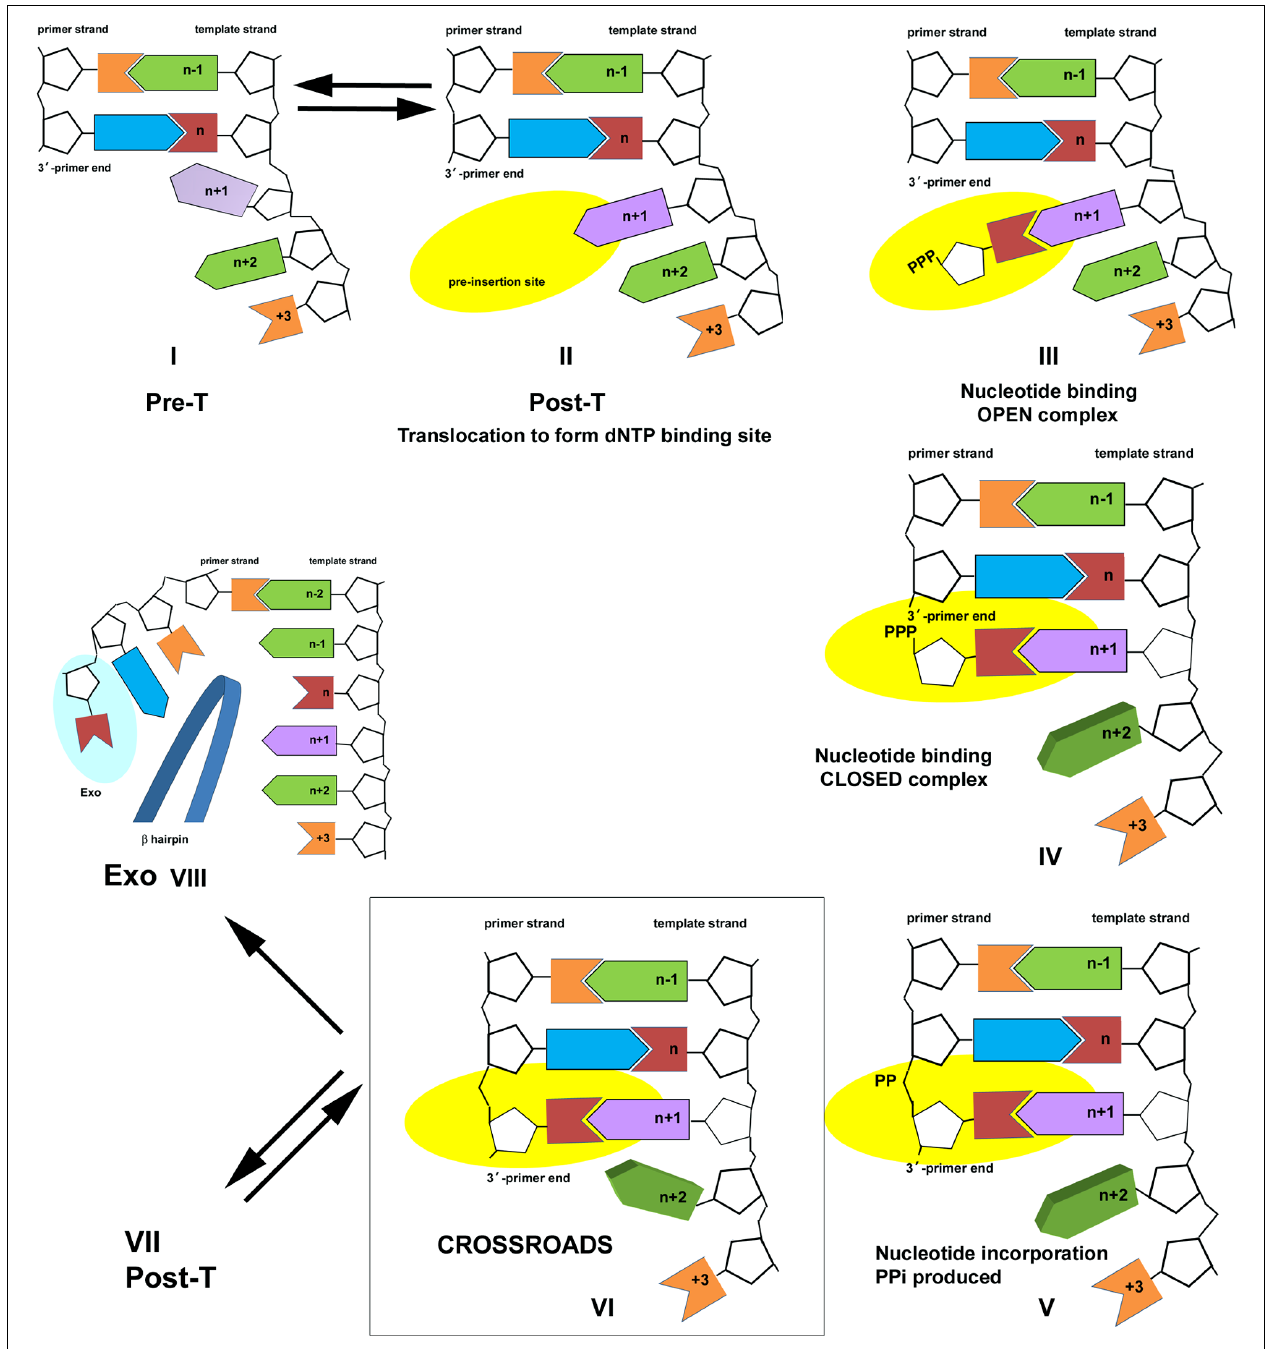
a new Pre-T, which is at the crossroads of three pathways. ComplexVI is in equilibrium with the Post-T complex (ComplexVII); binding the correct nucleotide starts another cycle of nucleotide incorporation. Alternatively, PPi may bind to ComplexVI to form ComplexV, which leads to the reverse reaction (pyrophosphorolysis). PAA, as a PPi mimic, also binds to ComplexVI. A third alternative is proofreading (ComplexVIII).The figure is modified from Reha-Krantz etal. (2011) and is shown with permission from the